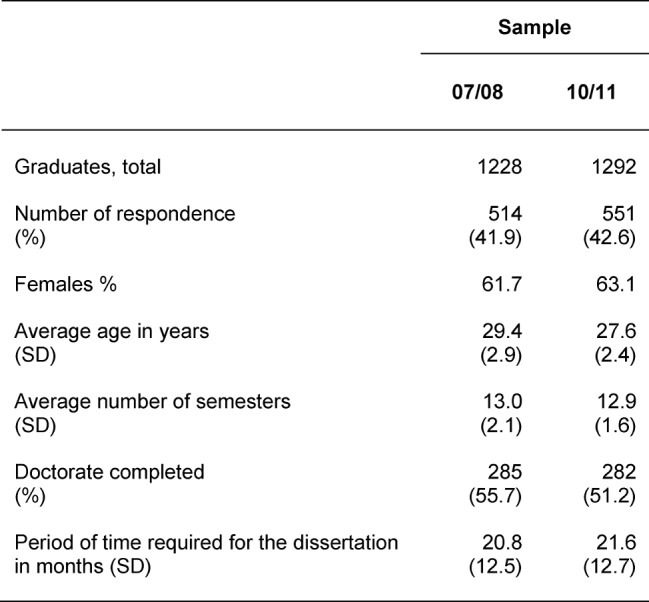
Sample Descriptions